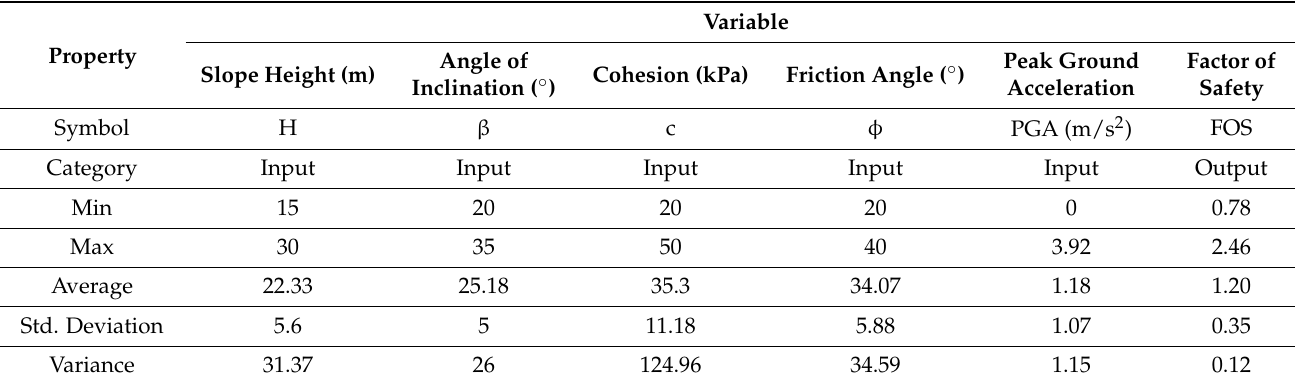
Table 2. Input and output variables for slope stability